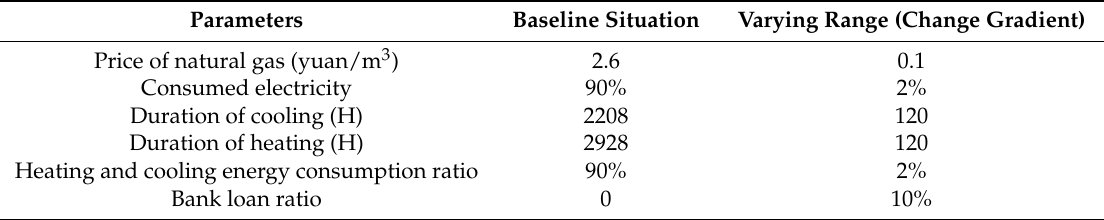
Table 8. Parameter settings under baseline situation.